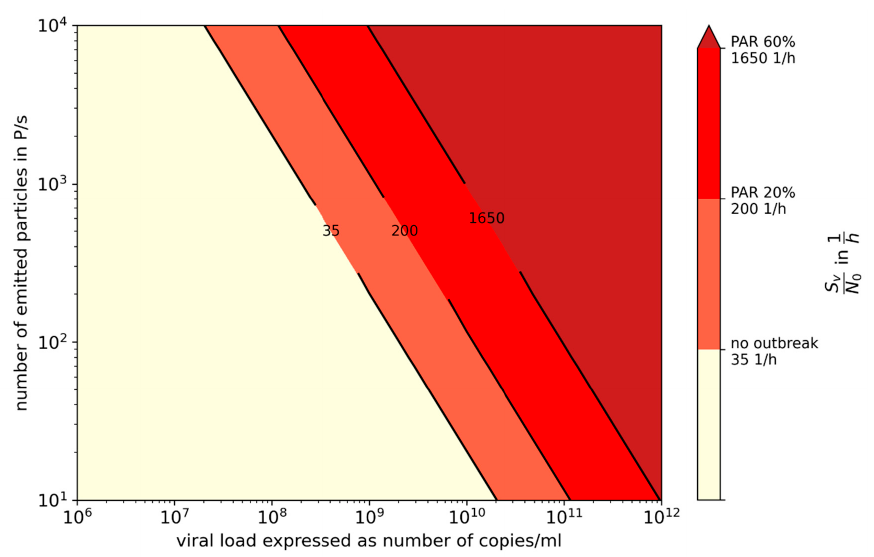
Figure 8. Viral emission for different viral loads and particle emission rates with N 0 = 67 viral copies; the attack rates found in the investigated outbreaks are shown with different colors.